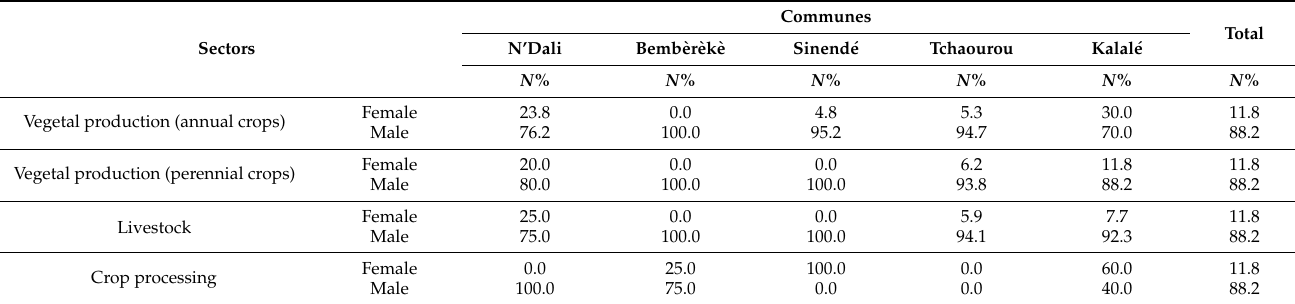
Table 4. Sectors of agricultural entrepreneurial activities.